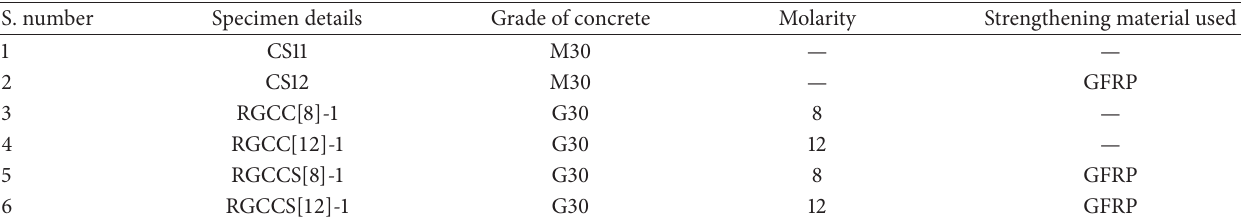
Table 3: Details of test specimens.